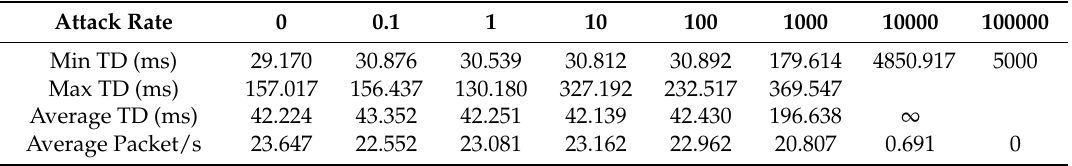
Table 1. The time delay caused by different DoS attack rates.